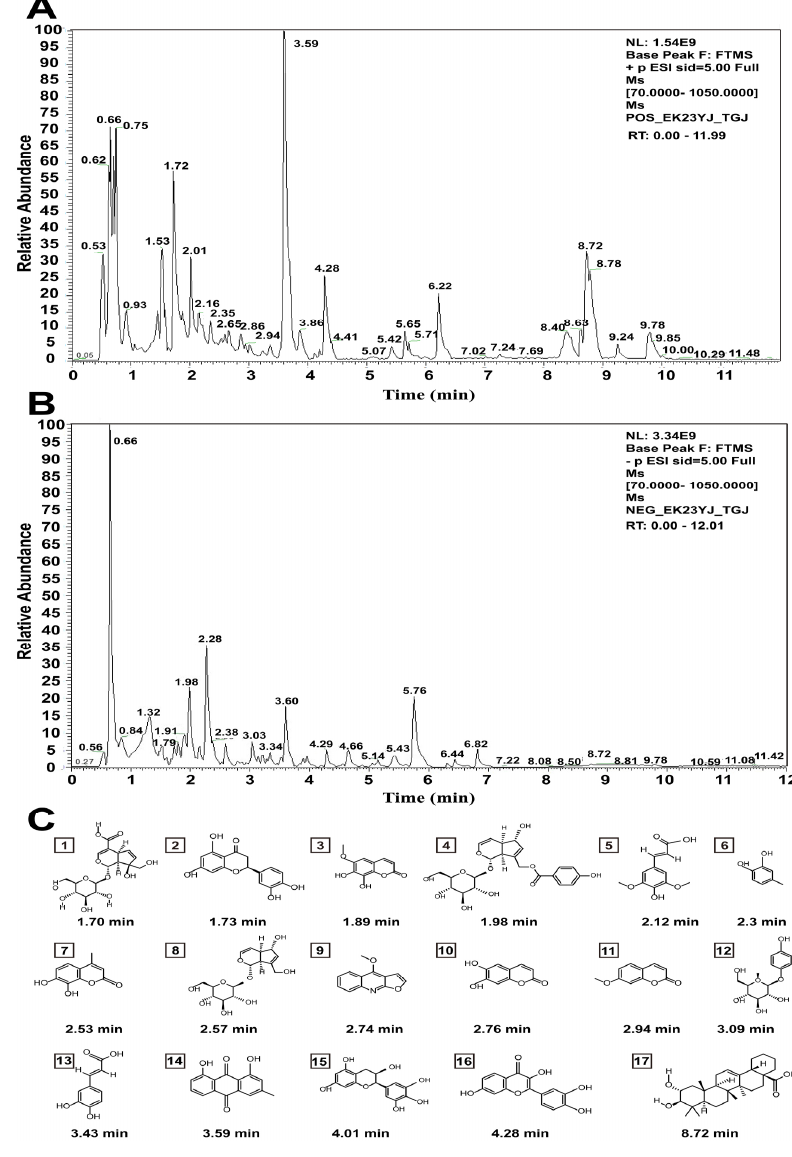
Figure 1. ( A , B ) The total ion current chromatogram of aqueous extracts of Cibotii rhizoma (AECRs): the positive mode ( A ); the negative mode ( B ). ( C ) Chemical structure of 17 compounds in AECRs . Table 1. The compounds of aqueous extracts of Cibotii rhizoma ( AECRs).